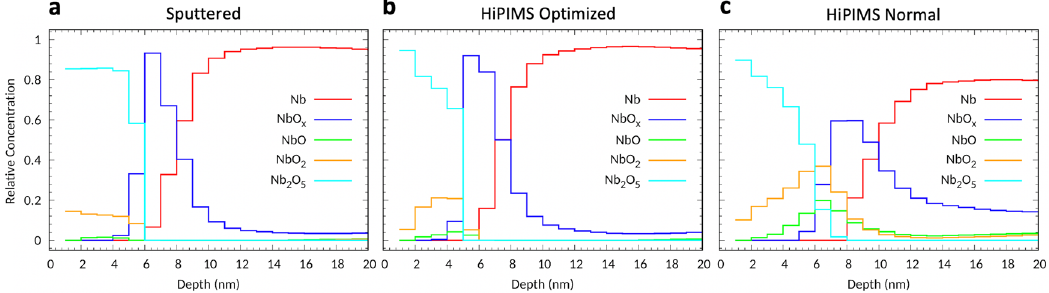
Fig. 3 Depth pro fi les of the different oxidation states of Nb. The pro fi les for the sputtered ( a ), HiPIMS optimized ( b ), and HiPIMS normal ( c ) Nb fi lms were reconstructed from PES data using a maximum-entropy method algorithm. Each fi lm shows a surface layer of a few nm of Nb 2 O 5 , a transition layer with varying concentrations of different suboxides, and the Nb metal bulk. In particular, the HiPIMS normal fi lm shows signi fi cant concentrations of NbO and NbO 2 in the transition layer and deeper penetration of NbO x into the ref. 45 . The main features of the DOS are consistent with the energy and relative intensities of the experimental peaks.